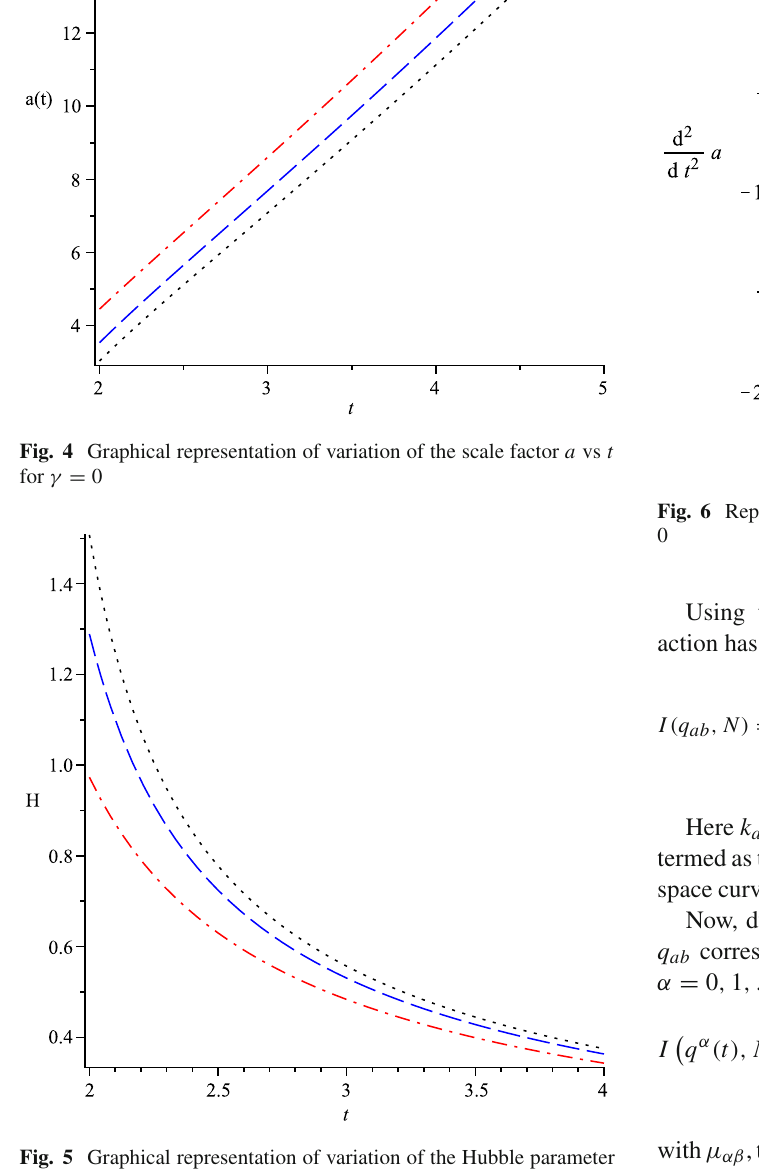
Fig. 5 Graphical representation of variation of the Hubble parameter H vs t for γ = 0